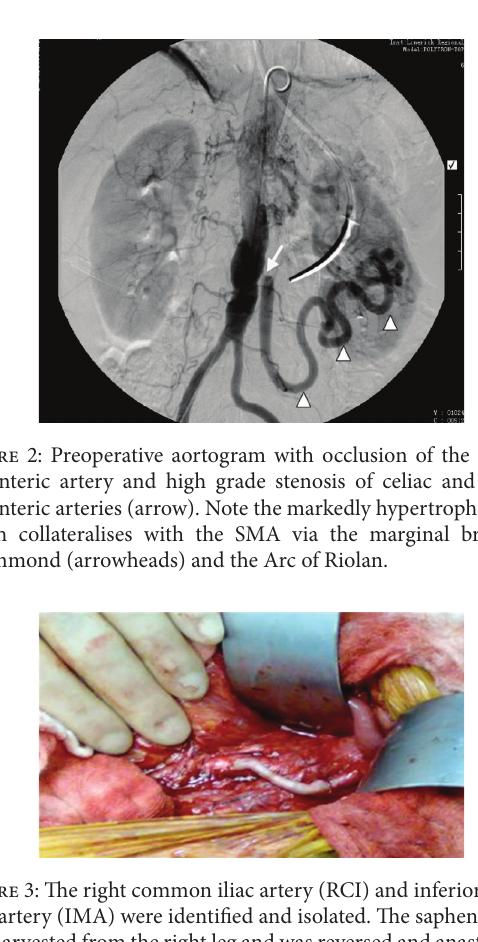
Figure 1: Abdominal CT scan with contrast demonstrating inflam- matory changes of the pericolonic fat in the right colon particularly around the cecal area.